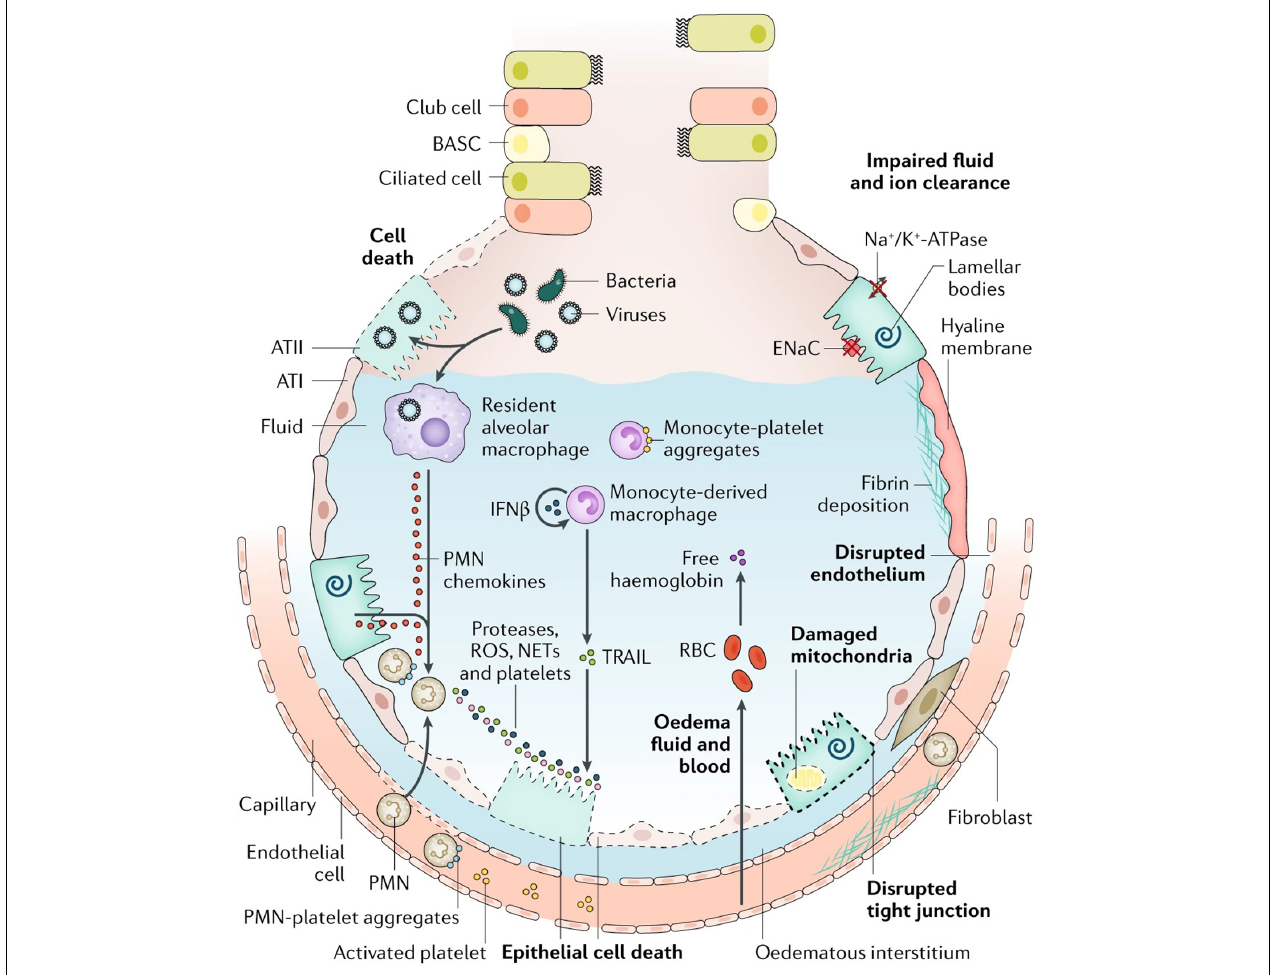
FIGURE 1 | Injured alveolus in the acute phase of lung injury and acute respiratory distress syndrome. A variety of insults (such as acid, viruses, ventilator-associated lung injury, hyperoxia, and bacteria) can injure the epithelium, either directly or by inducing inflammation, which in turn injures the epithelium. Direct injury is inevitably exacerbated by a secondary wave of inflammatory injury. Activation of toll-like receptors (not shown) on alveolar type II (ATII) cells and resident macrophages induces the secretion of chemokines, which recruit circulating immune cells into the airspaces. As neutrophils migrate across the epithelium, they release toxic mediators, such as proteases, reactive oxygen species (ROS), and neutrophil extracellular traps (NETs), which have an important role in host defense but cause endothelial and epithelial injury. Monocytes also migrate into the lungs and can cause an injury, such as epithelial cell apoptosis via IFN β -dependent release of tumor necrosis factor (TNF)-related apoptosis-inducing ligand (TRAIL), which activates death receptors. Activated platelets form aggregates with polymorphonuclear (PMN) leukocytes, which are involved in NET formation, and monocyte–platelet aggregates. Red blood cells (RBCs) release cell-free hemoglobin, which exacerbates injury via oxidant-dependent mechanisms. Angiopoietin 2 inhibits TIE2-stabilization of vascular endothelial cadherin (VE-cadherin); vascular endothelial growth factor and other permeability-promoting agonists also destabilize VE-cadherin via dissociation from p120-catenin, resulting in its internalization and enhanced paracellular permeability. Additionally, loss of cell–cell adhesion in the setting of actomyosin contraction results in the formation of occasional gaps between endothelial cells. Epithelial injury also includes wounding of the plasma membrane, which can be induced by bacterial pore-forming toxins or mechanical stretch, and mitochondrial dysfunction. Together, these effects result in endothelial and epithelial permeability, which further facilitates the transmigration of leukocytes and leads to the influx of edematous fluid and RBCs. Airspace filling with edematous fluid causes hypoxemia, resulting in the need for mechanical ventilation. Vascular injury and alveolar edema contribute to the decreased ability to excrete CO 2 (hypercapnia), accounting for the elevated pulmonary dead space in acute respiratory distress syndrome. In turn, hypoxemia and hypercapnia impair vectorial sodium transport, reducing alveolar edema clearance. ATI, alveolar type I cell; BASC, bronchioalveolar stem cell; ENaC, epithelial sodium channel. Reproduced with permission (Ware and Matthay,